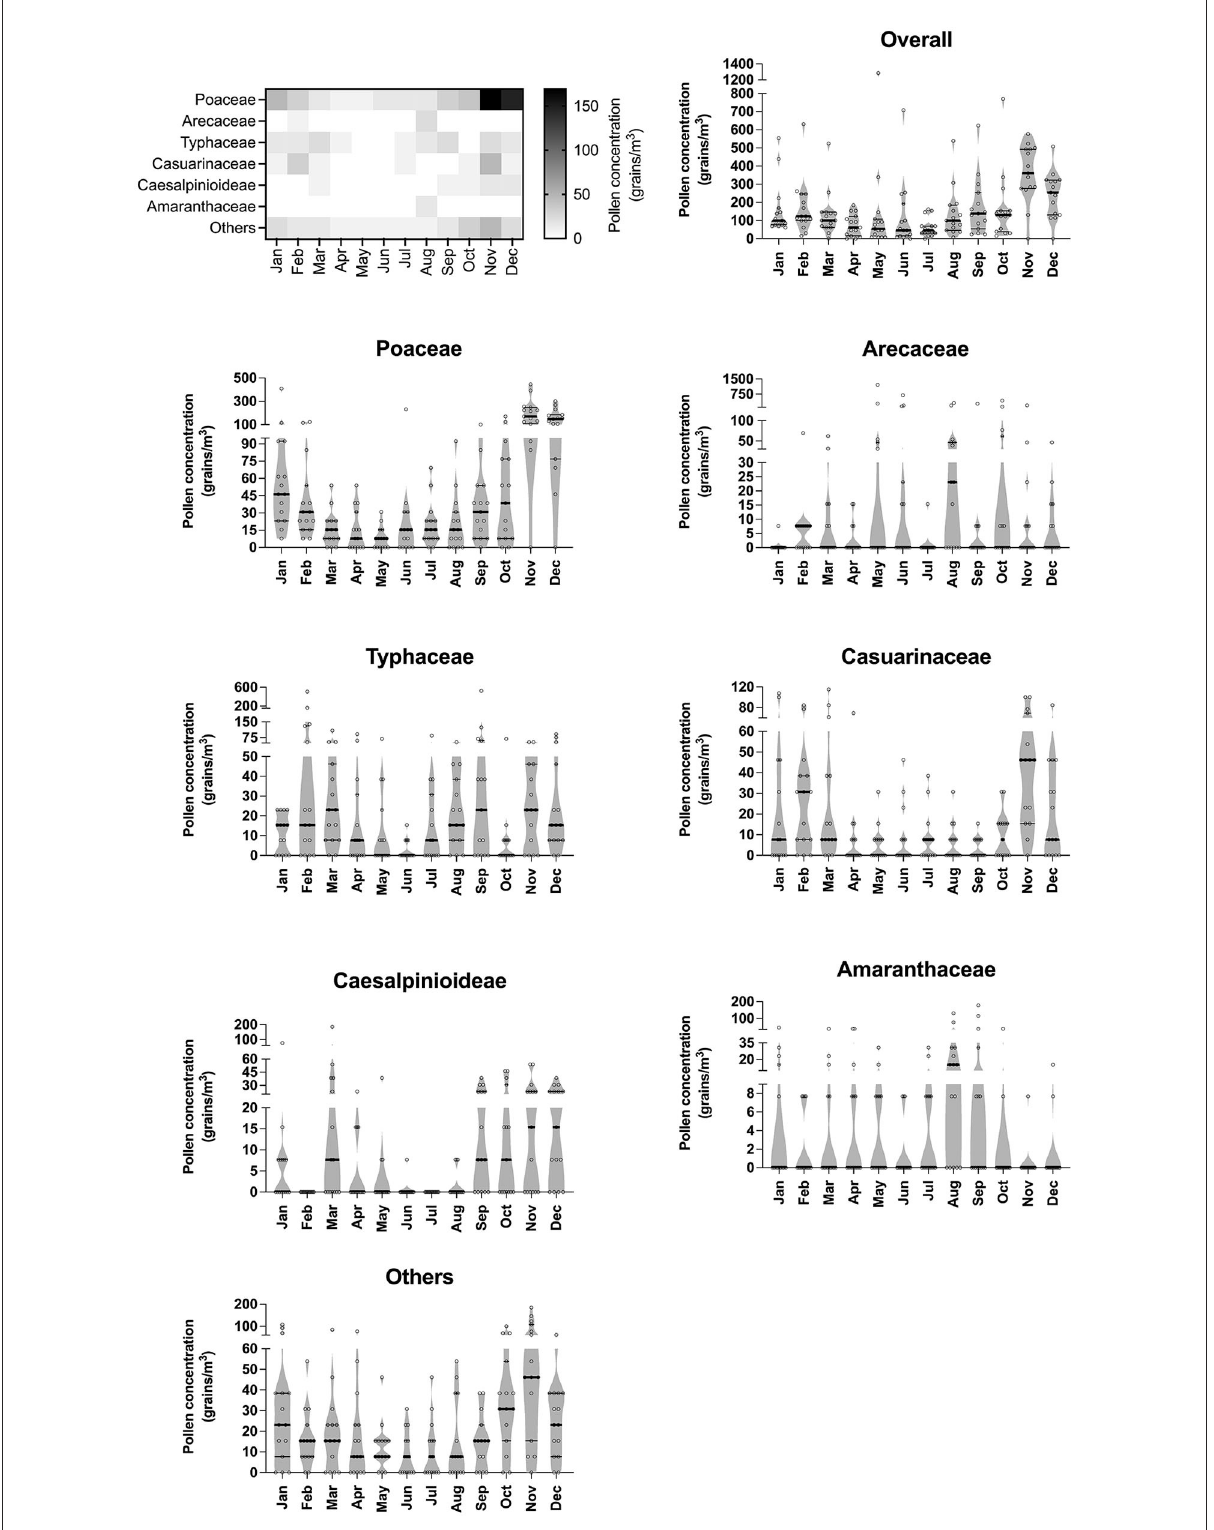
FIGURE1 Variations of pollen quantity throughout seasons. Heat map generated based on the median of each pollen species illustrates airborne pollen distribution throughout the year. Error bars of violin plots represent median and interquartile